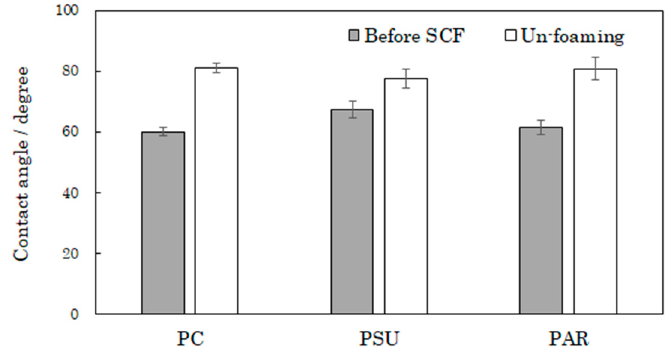
Figure 5. Contact angles of PC, PSU, and PAR before and after supercritical treatment.